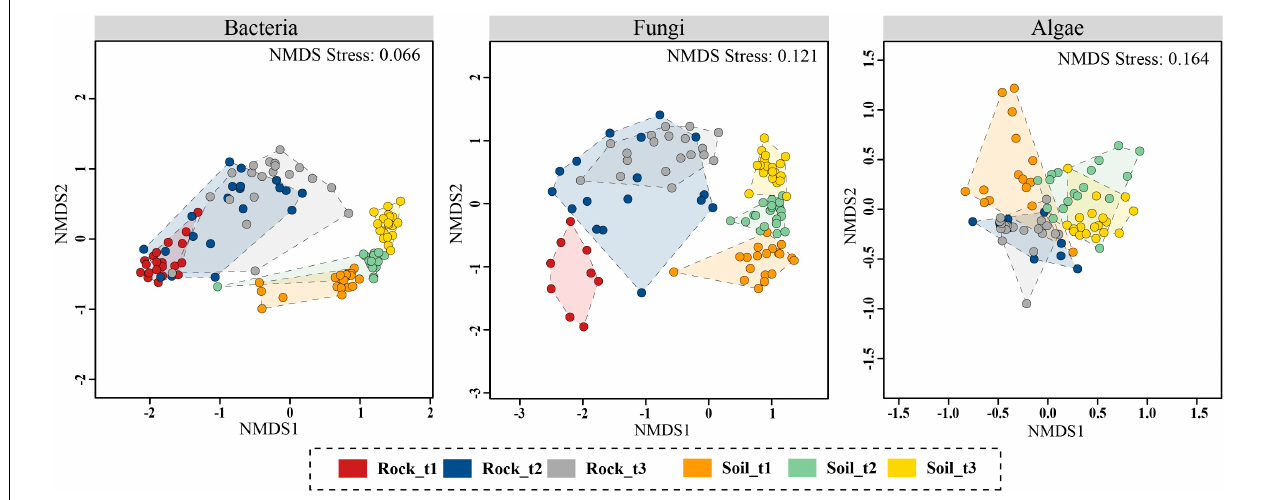
FIGURE 4 | Non-metric multidimensional scaling (NMDS) ordination plots of Bray–Curtis dissimilarities for bacterial, fungal and algal communities across sample categories (i.e., substrate type plus successional stage). Analyses were based on OTU data matrices. Results using ASV data are Supplementary Figure S12 .